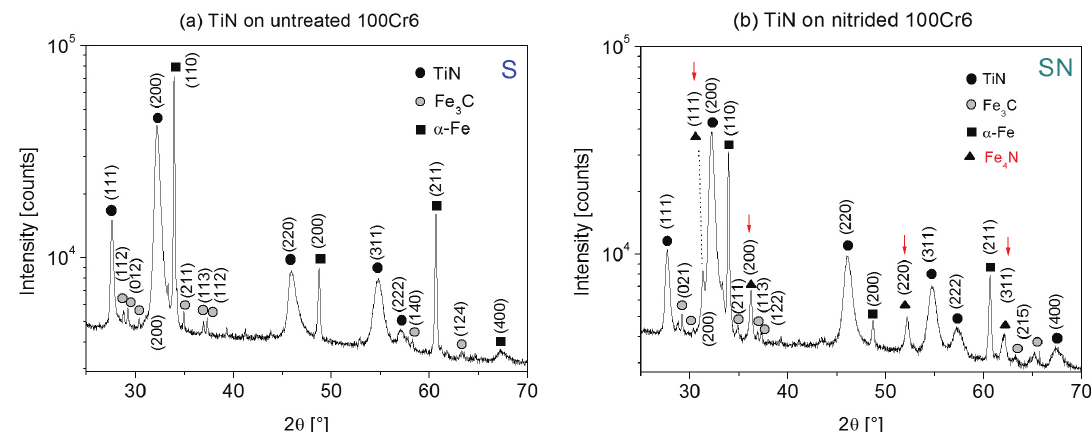
Figure 2. Grazing incidence X-ray diffraction patterns obtained for (a) untreated S(TiN) and (b) nitrided SN(TiN)